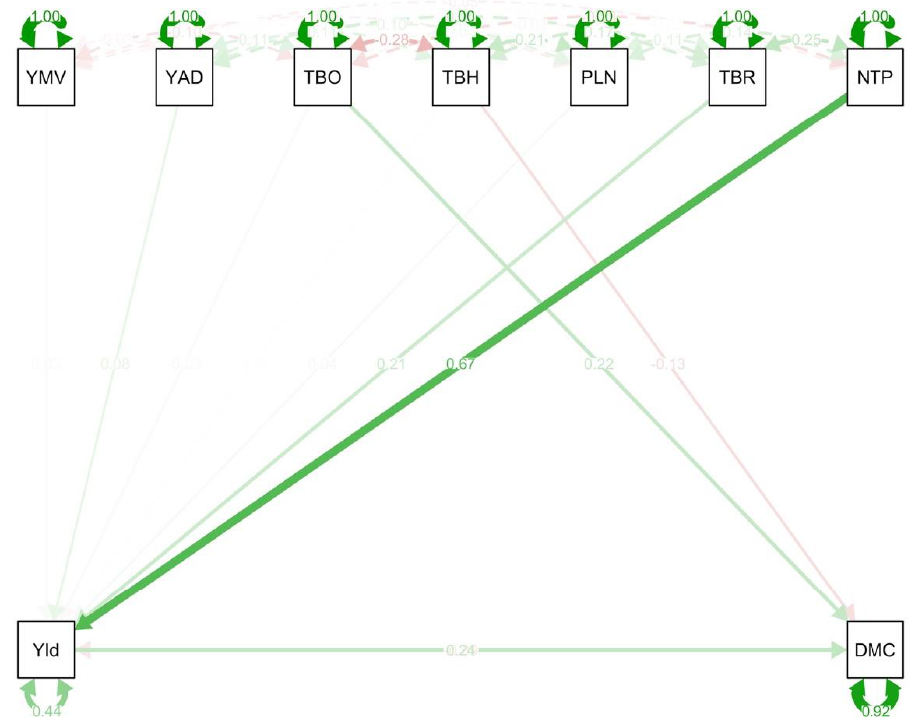
Figure 4. Path coefficient analysis between response and independent yam variables. DMC = Dry matter content, YMV = Yam mosaic virus, YAD = Yam anthracnose disease, TBOXI = Tuber flesh oxidation, TBHard = Tuber flesh hardness, PLNV = Plant vigour, TBRSZ= Tuber size, NTP = Number of tubers per plot. Red colour showed negative correlation while the green colour showed positive correlation.